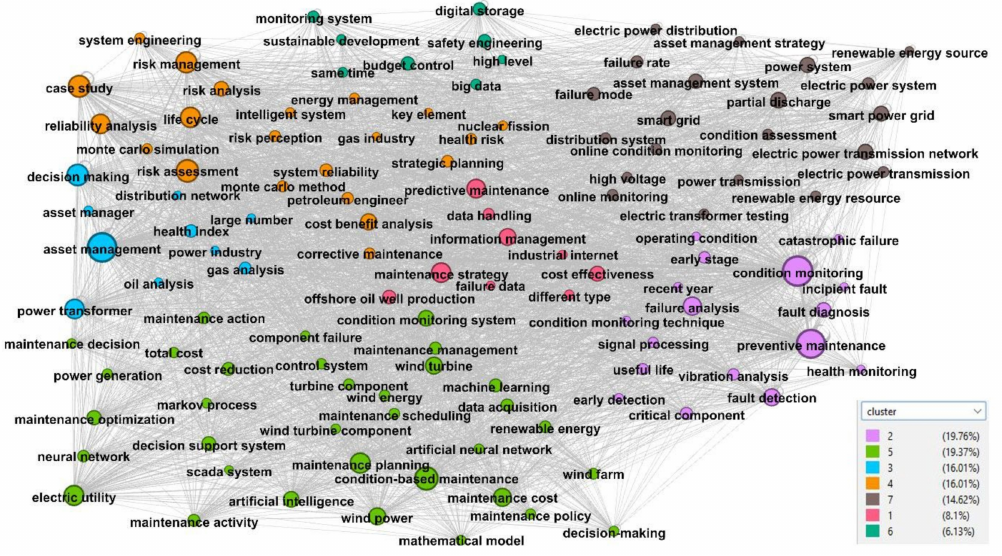
Figure 4. Cluster visualization of keyword co-occurrence